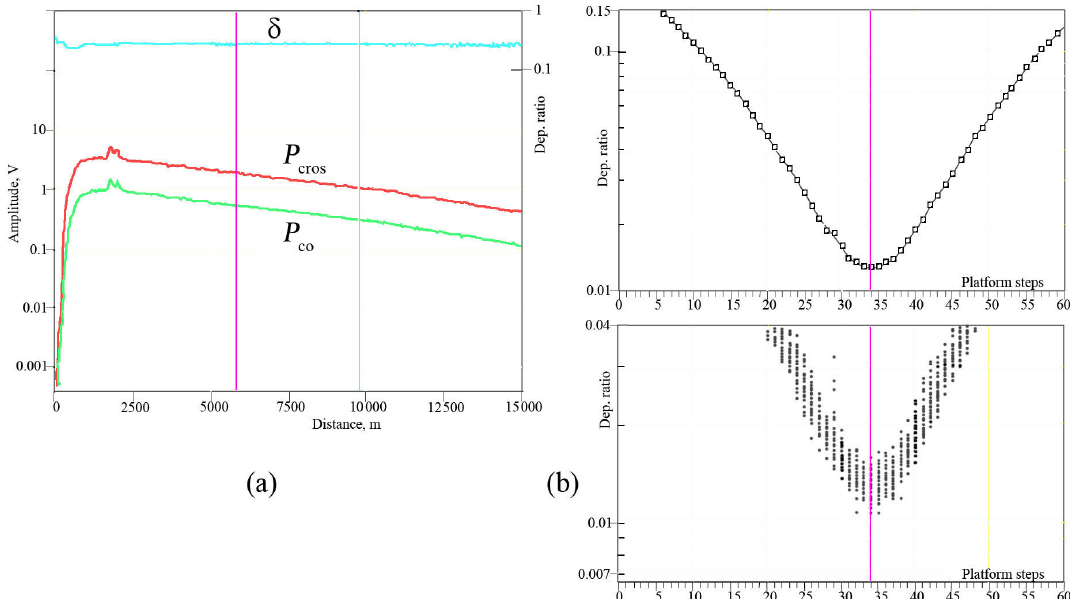
Figure 5. (a) Lidar signals from two photodetectors ( P co and P cros ), summarized over all positions of plate B (red and green lines). A height range of 6–9km with constant depolarization ratio (blue line) is chosen to adjust the plates. (b) Depolarization ratio for each pulse (bottom) and averaged over a 30min record (top).